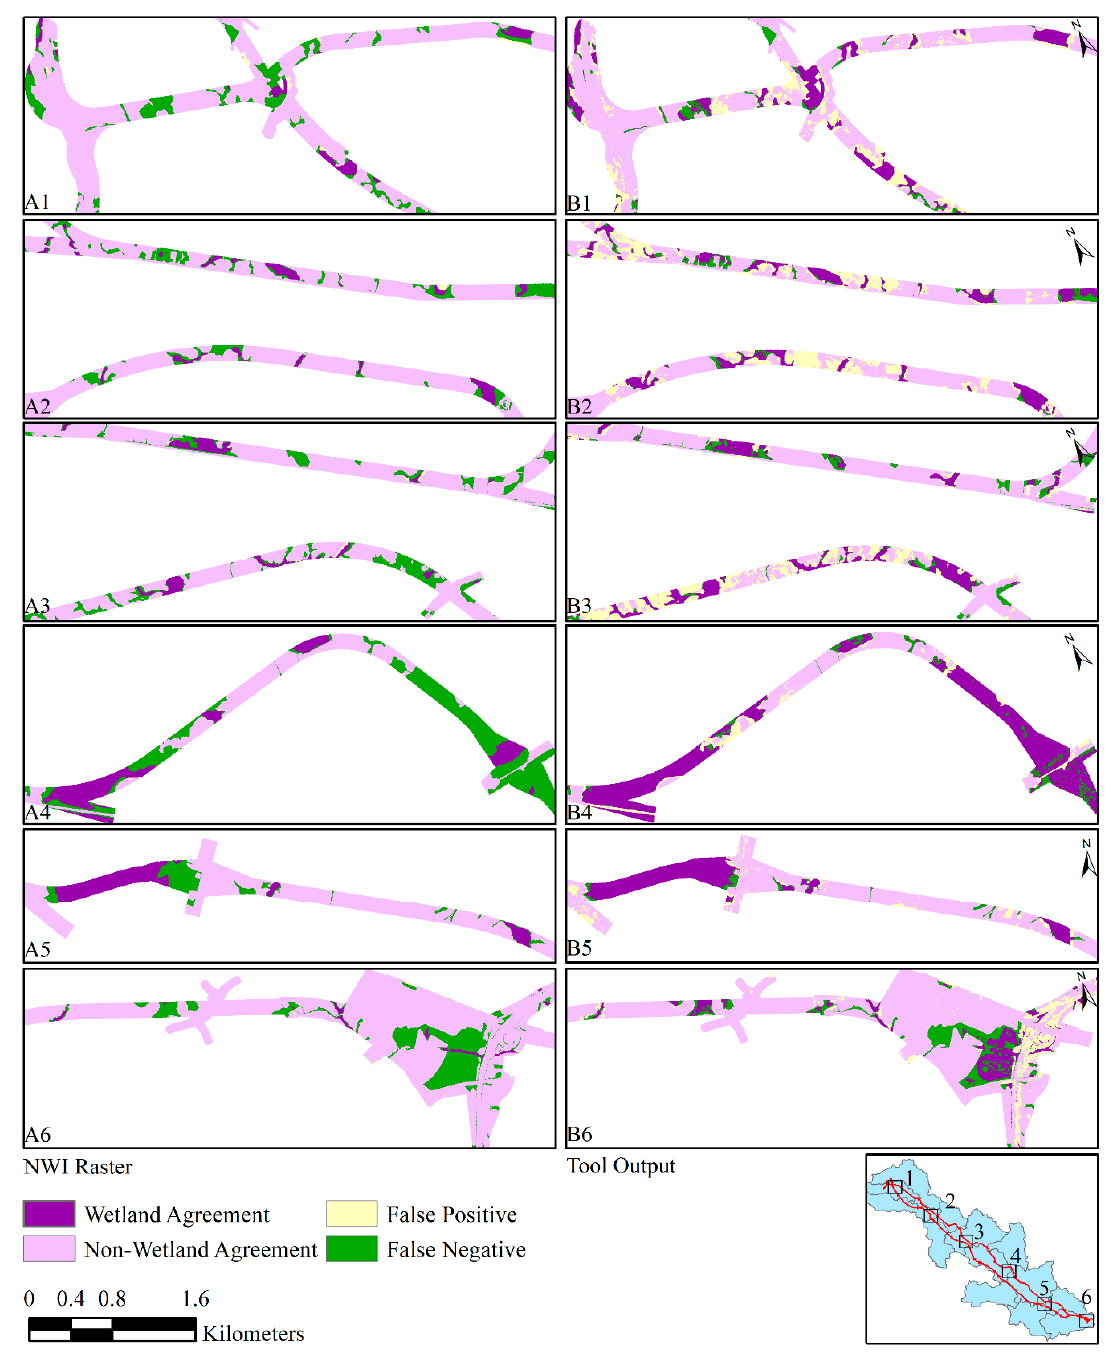
Figure 6. Level of agreement between NWI maps ( A1 – A6 ) and tool output ( B1 – B6 ) compared to